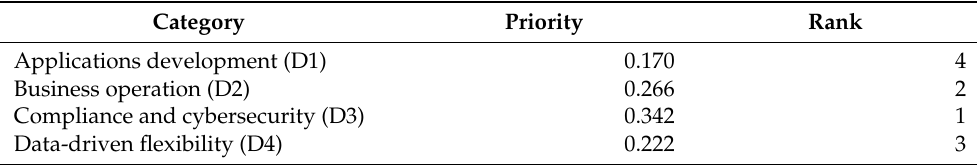
Table 7. Consolidated priorities for main CSF dimensions.